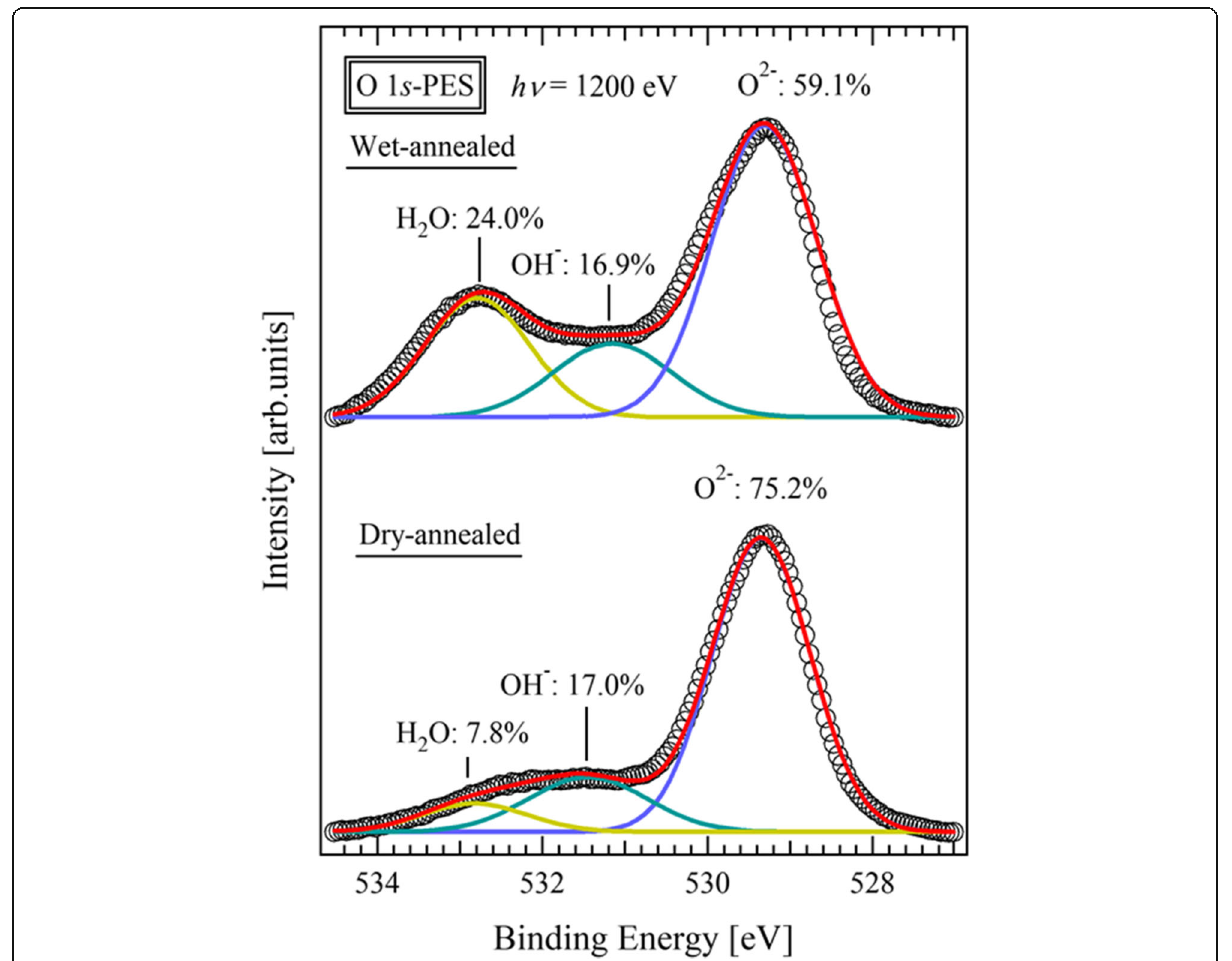
Fig. 5 PES spectra of the O 1 s core level of dry- and wet-annealed thin films. The blue, green, and yellow curves are the O 2 − in the lattice site, and OH − and H 2 O on the surface, respectively, obtained from Gaussian